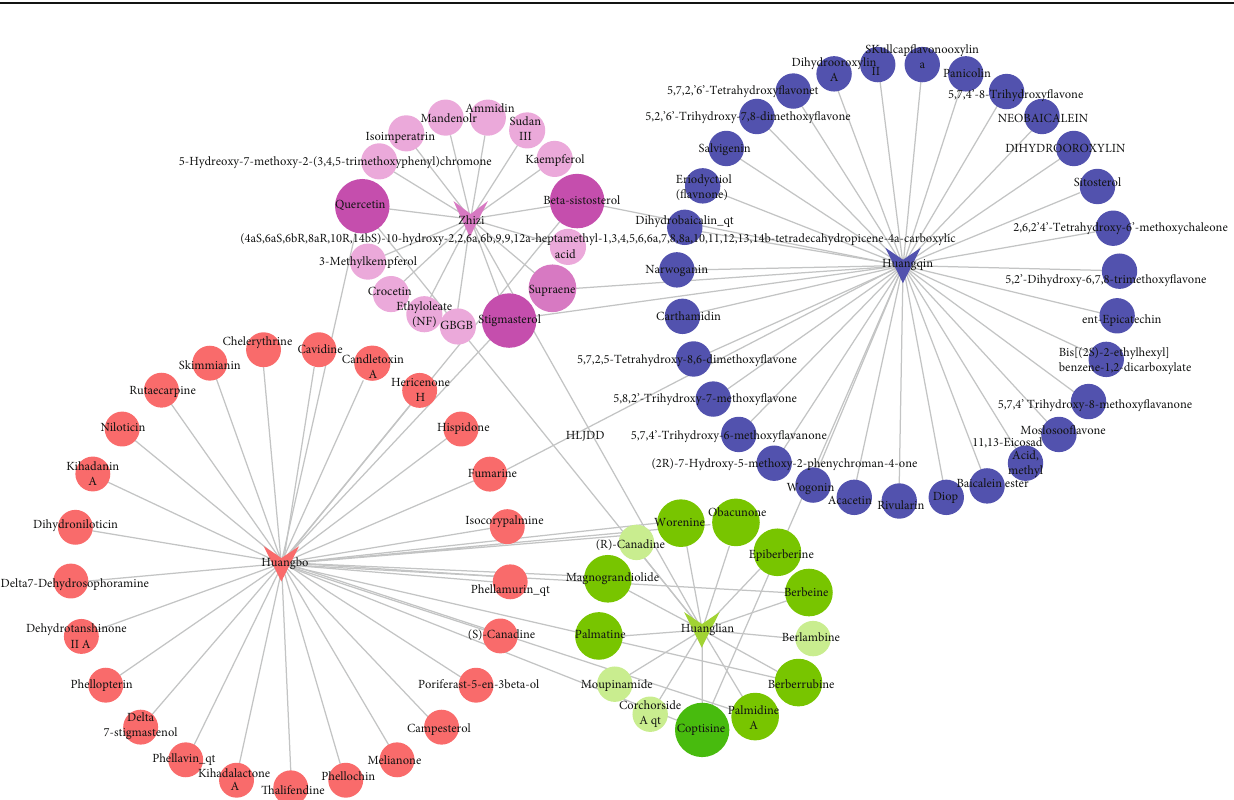
Figure 2: Network of HLJDD ’ s active components. HLJDD formula is consists of HL, HQ, HB, and ZZ. V corresponds to 4 herb nodes. Green, dark blue, red, and purple circles employed to stand for compounds of HL, HQ, HB, and ZZ, respectively. Node size of the compound is proportional to the number of Chinese medicines connected, indicating that di ff erent Chinese medicines contain the same chemical